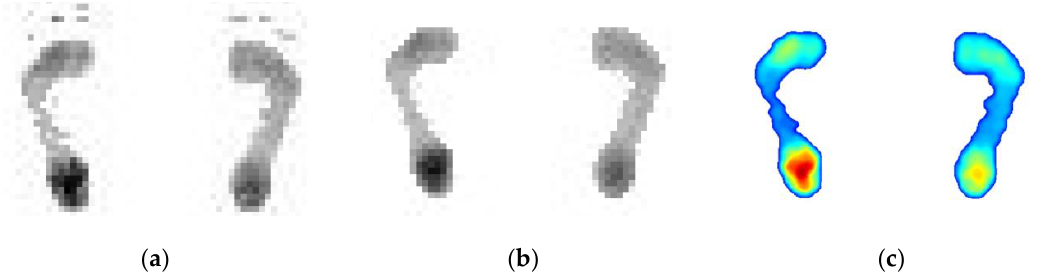
Figure 11. The results of automatic processing based on the proposed method for the normal feet. ( a ) is the original plantar pressure image of the normal feet, ( b ) is result after using the proposed method and ( c ) is the interpolation color image of ( b ).